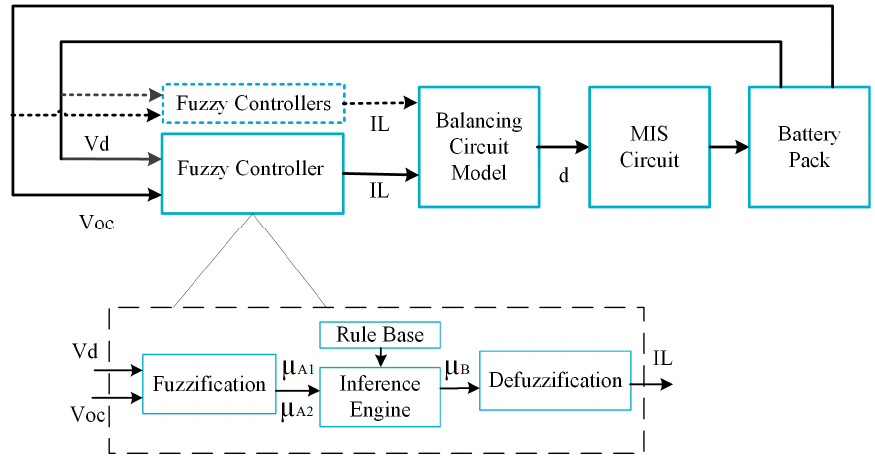
Figure 6. Block diagram of an FL controller of MISBC.